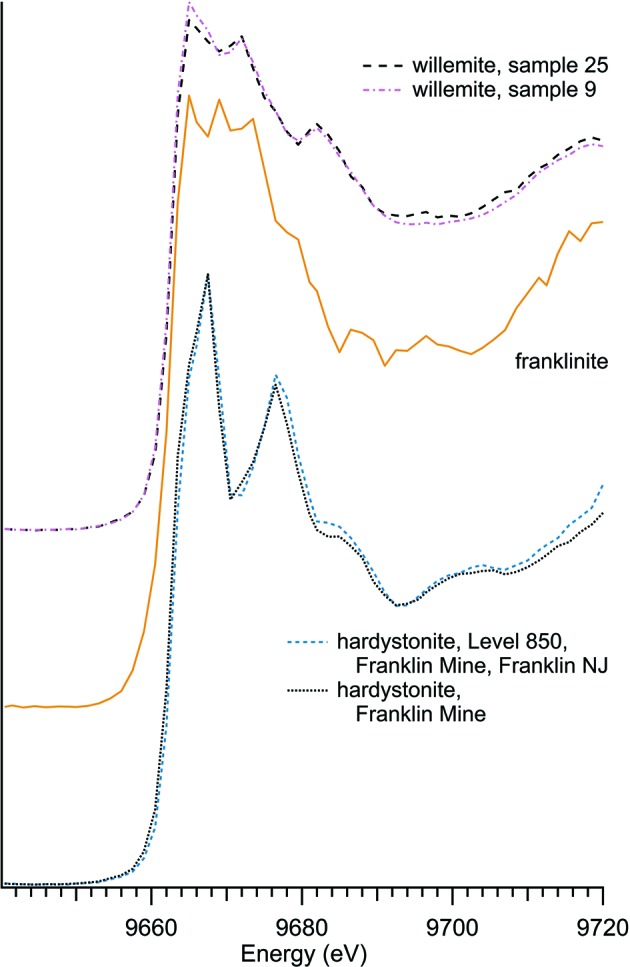
Comparison of franklinite specra with zinc silicates.